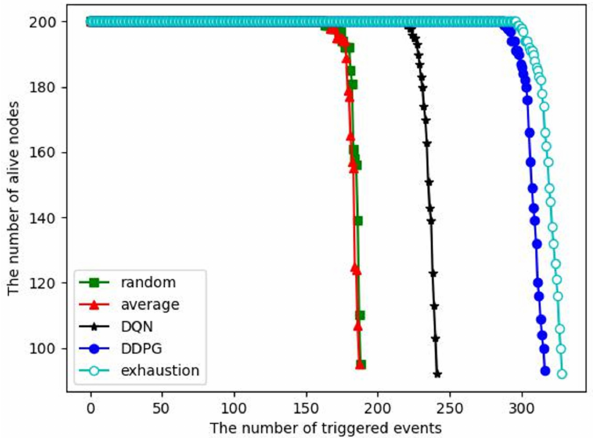
Figure 10. The number of alive nodes versus the number of triggered